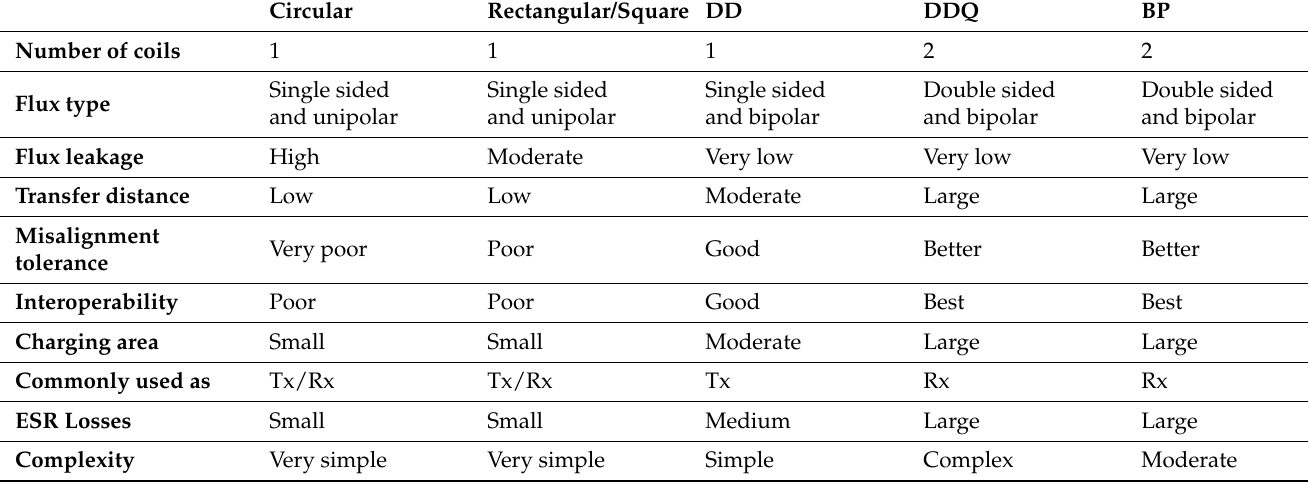
Table 2. Comparison of different types of coils